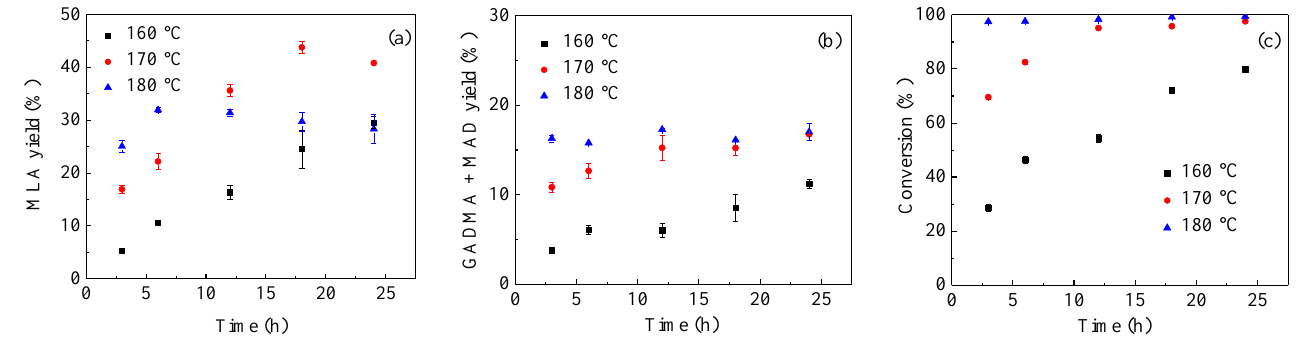
Figure 5. Effect of reaction time and temperature on the conversion of HFCS-55: ( a ) MLA yield, ( b ) GADMA + MAD yield, ( c ) conversion of sugars. Reaction conditions: HFCS-55, 0.06 g; methanol, 6 mL; c-Co 0.25 , 0.03 g. Table 2. Catalytic conversion of HFCS-55 with additional water.